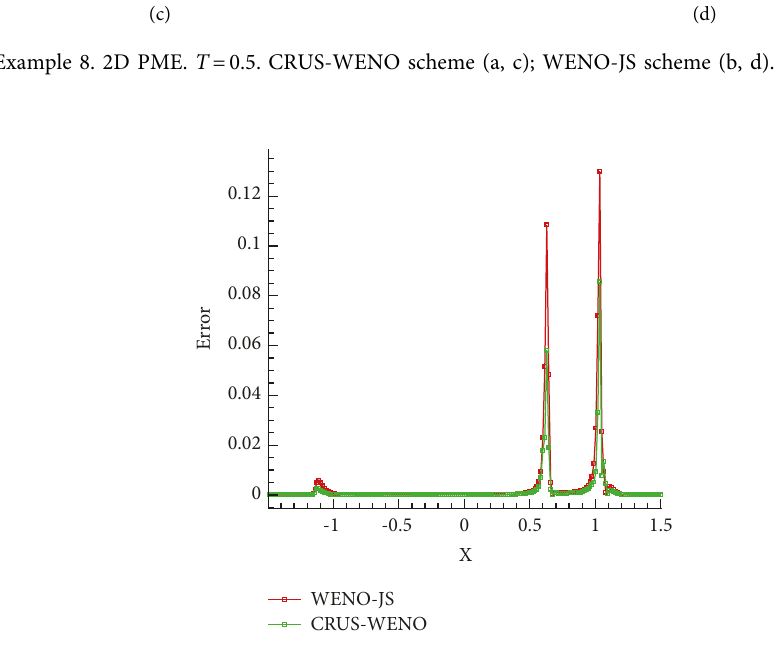
Figure 11: Example 8. 2D PME. T � 0.5. Errors of WENO-JS scheme and CRUS-WENO scheme with 200 × 200 grid points along x � 0. The reference solution is computed by WENO-JS scheme with 800 × 800 grid